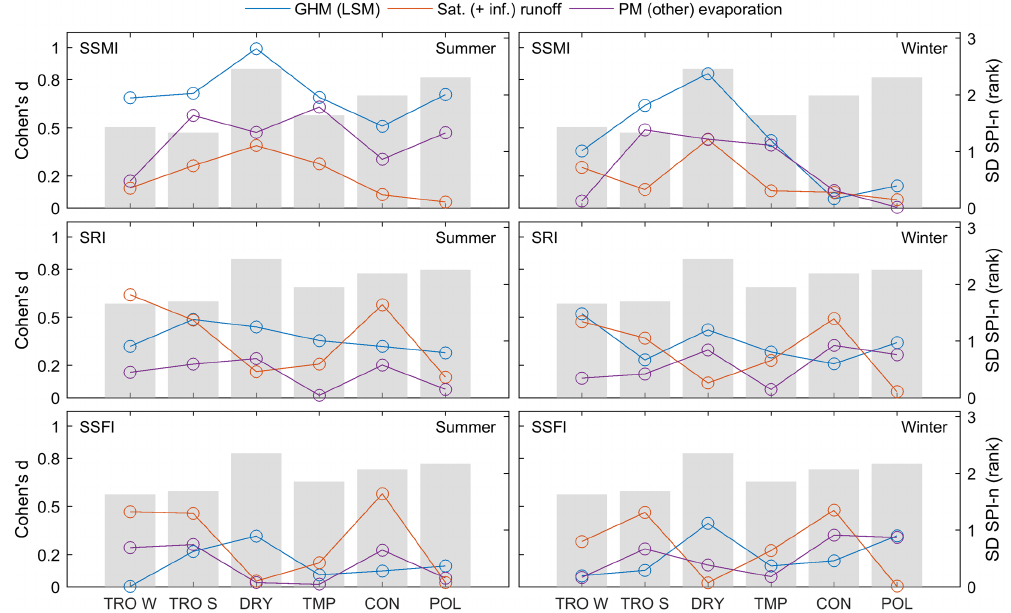
Figure 7. Effect sizes based on Cohen’s d for model structural choices by climate for summer and winter droughts in SSMI, SRI, and SSFI. Bars represent the standard deviation of model SPI-n for each group. Abbreviations of climate types are the same as in Fig.